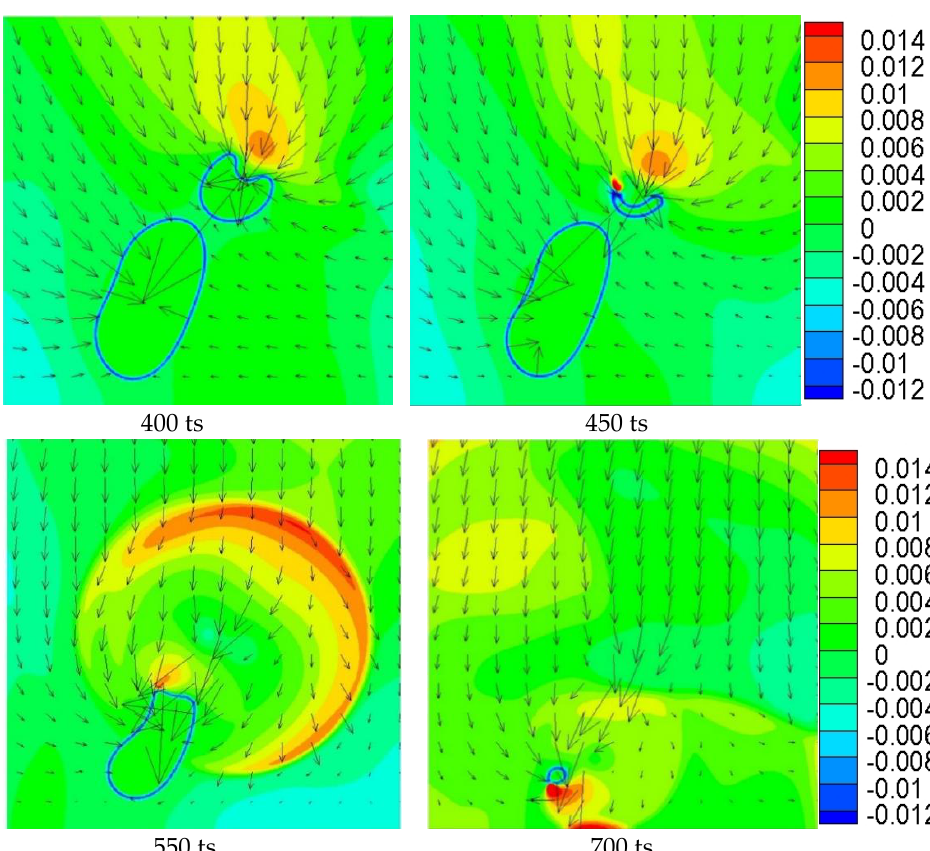
Figure 8. Pressure field and velocity field of cavitation bubble collapse.